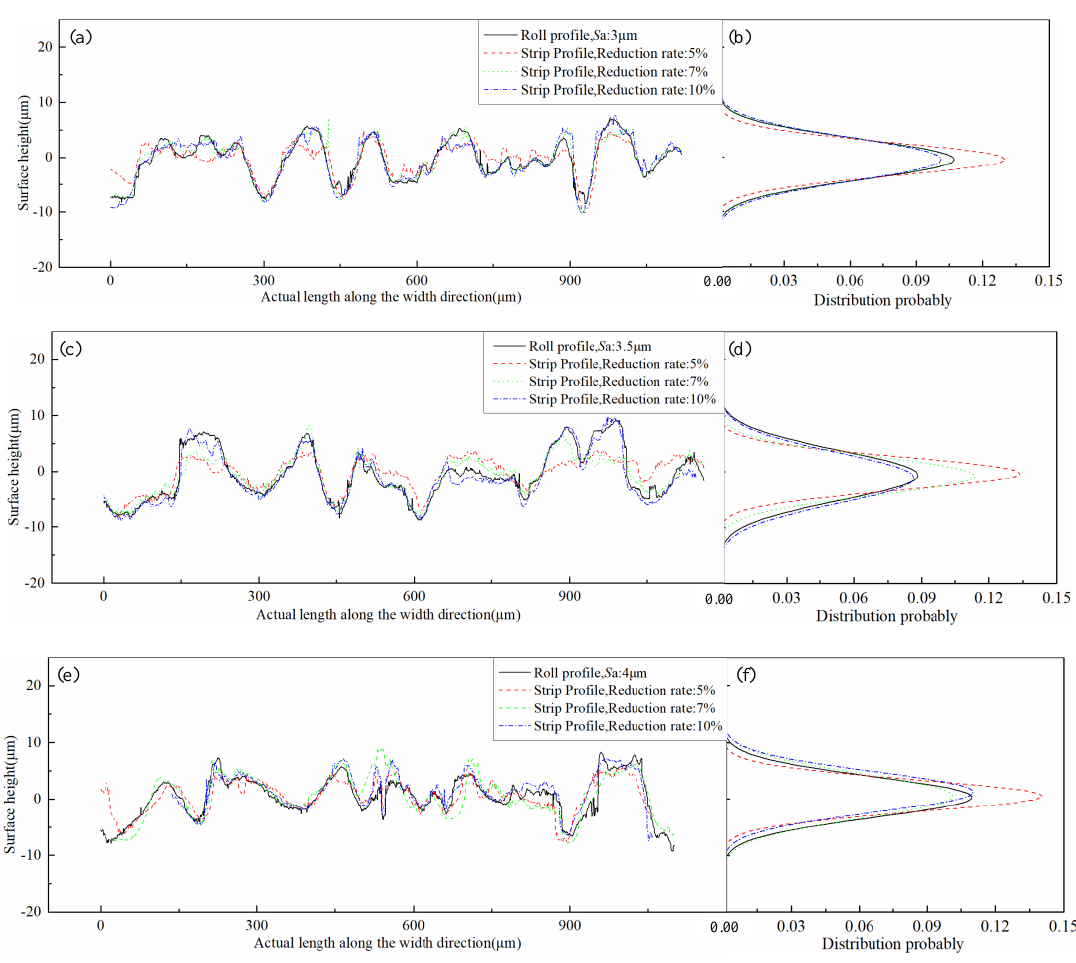
Figure 11. Surface topography of roll and strip under di ff erent roll roughness and reduction rates along the width direction: ( a ) profile of roll and strips (3 µ m roll roughness, 5 / 7 / 10% reduction), ( b ) height distribution of roll and strips (3 µ m roll roughness, 5 / 7 / 10% reduction), ( c ) profile of roll and strips (3.5 µ m roll roughness, 5 / 7 / 10% reduction), ( d ) height distribution of roll and strips (3.5 µ m roll roughness, 5 / 7 / 10% reduction), ( e ) profile of roll and strips (4 µ m roll roughness, 5 / 7 / 10% reduction), ( f ) height distribution of roll and strips (4 µ m roll roughness, 5 / 7 / 10% reduction).